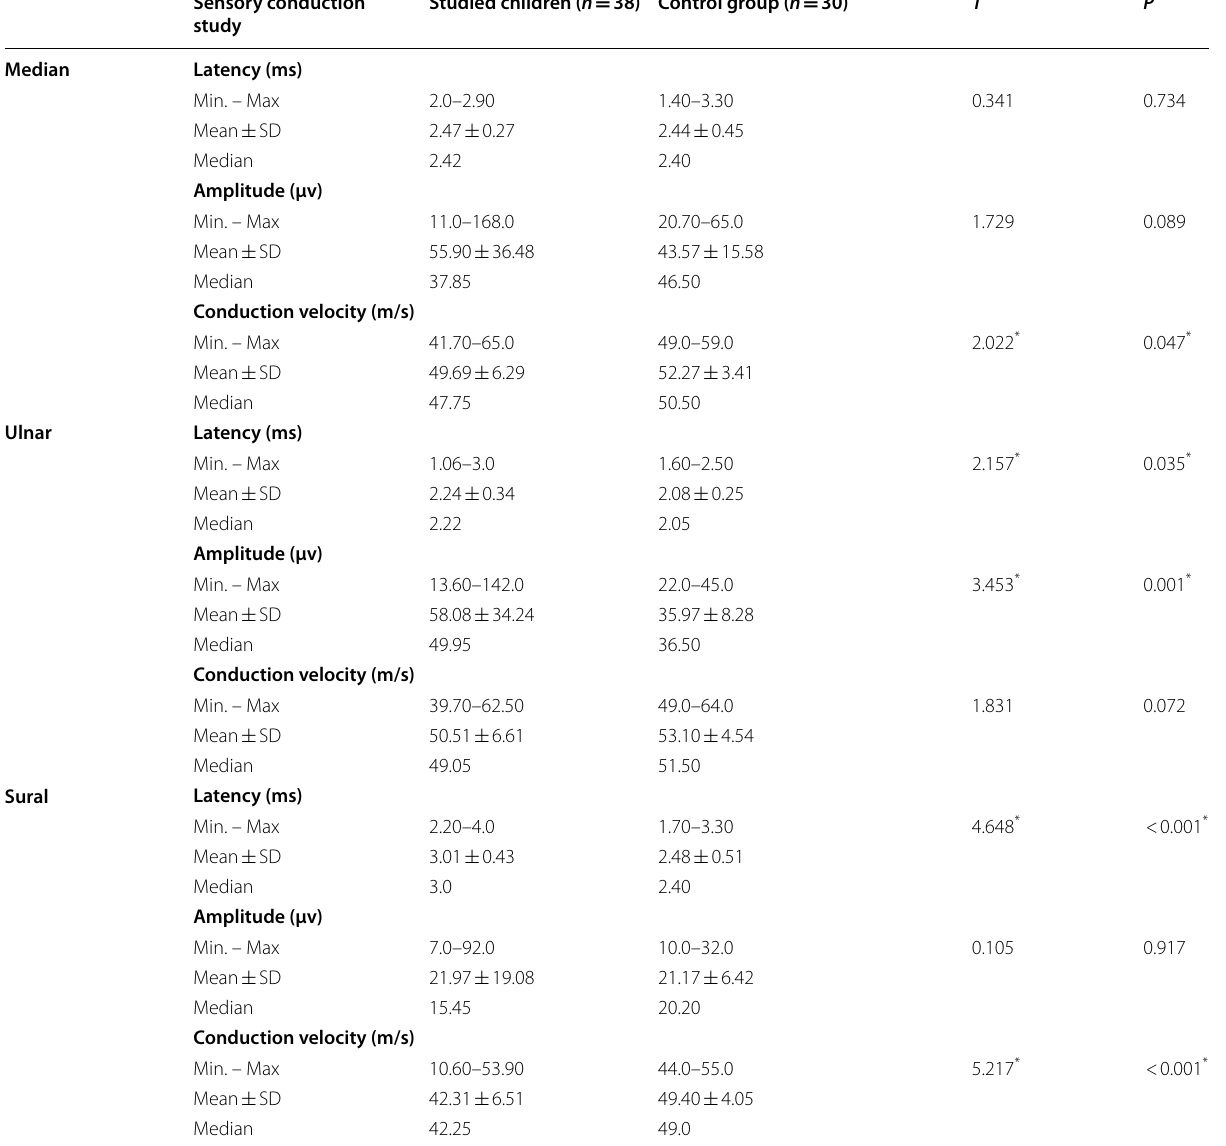
t Student’s t test. P P value for comparing between the two groups * Statistically significant at P ≤